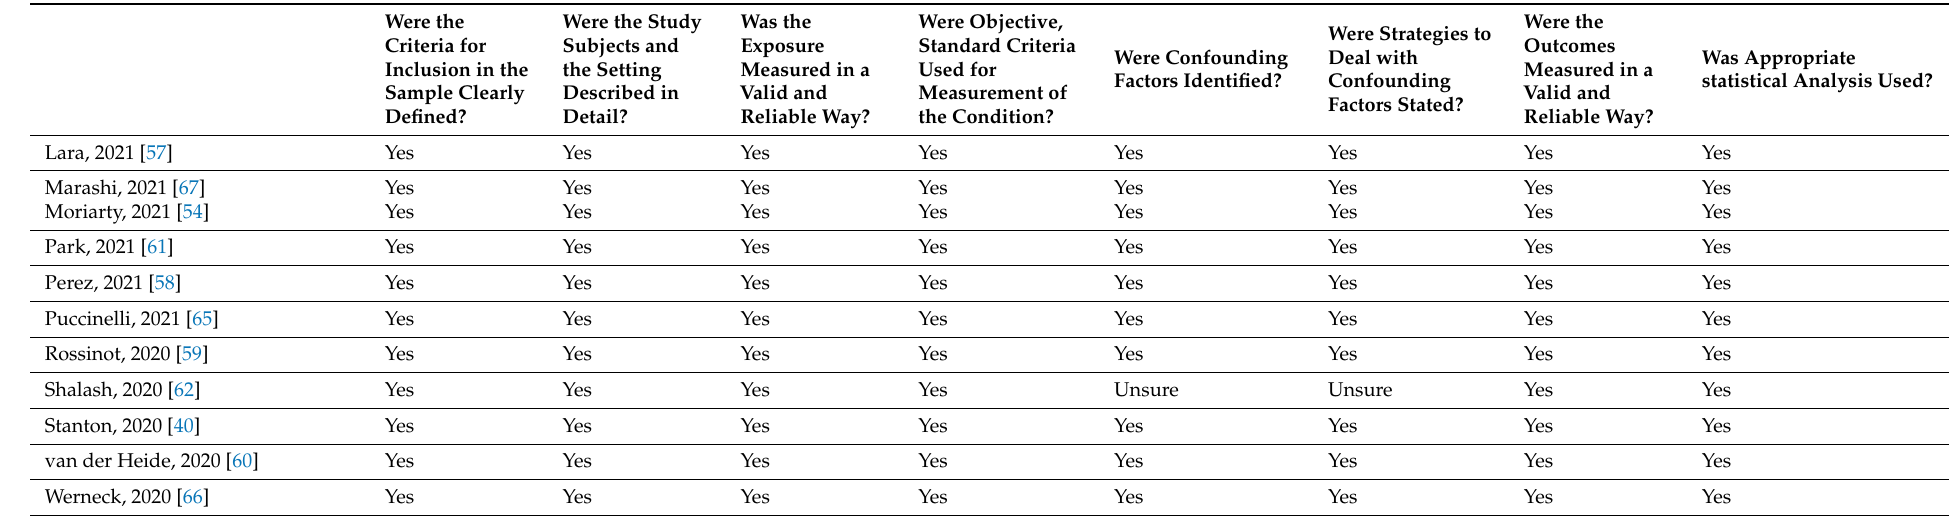
Table A3. JBI critical appraisal